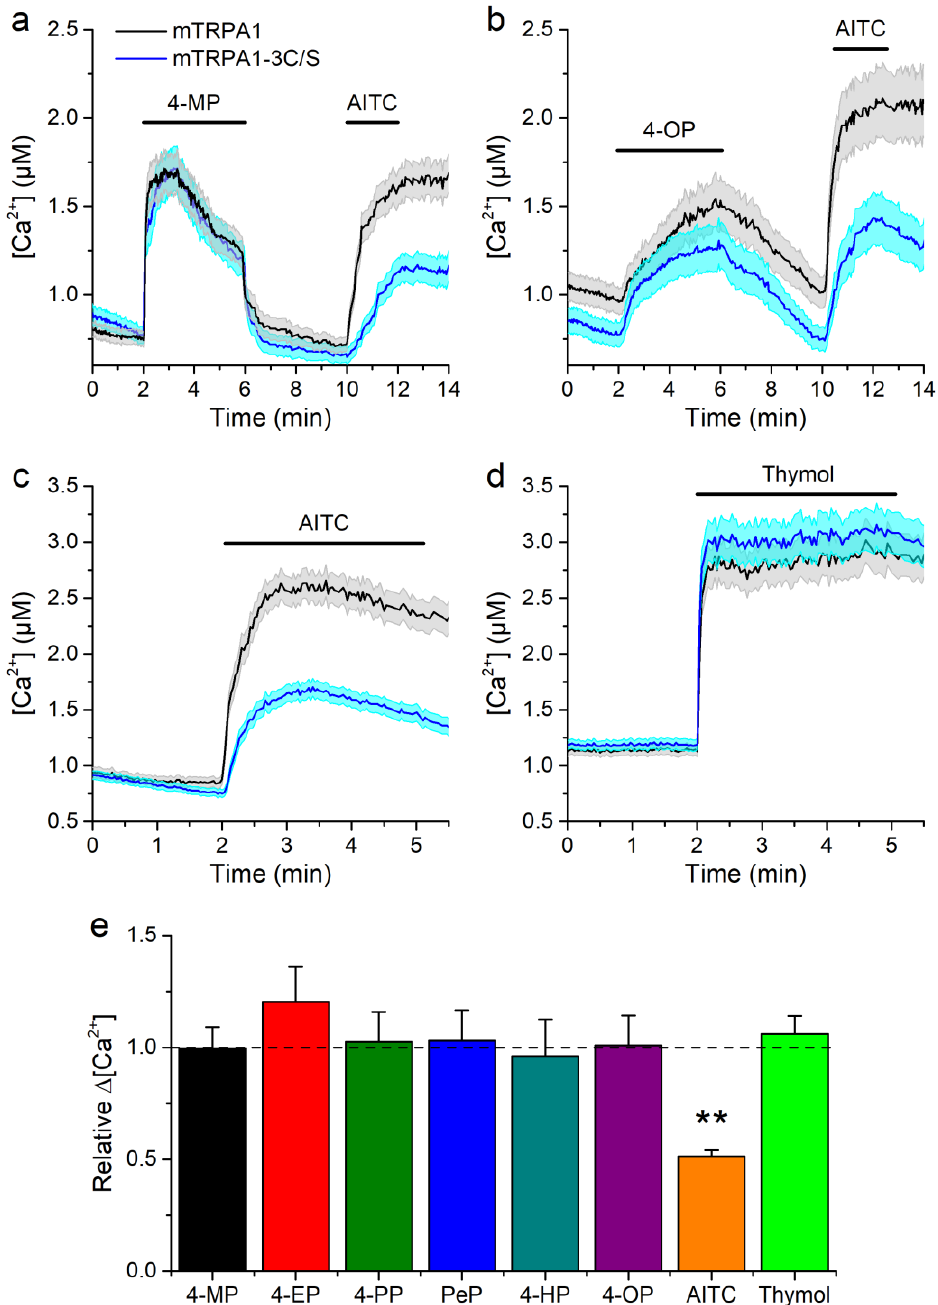
Figure 4. Responses to alkylphenols are not affected by mutation of mTRPA1 N-terminal essential residues. ( a – d ) Average traces of [Ca 2+ ] levels recorded in cells transfected with the wild type mTRPA1 or the triple cysteine mutant (mTRPA1-3C/S) in the presence of ( a , b ) 4-methylphenol, 1300 µ M ( c , d ) 4-octylphenol, 3.8 µ M and TRPA1 agonist AITC, 100 µ M. ( e ) Average [Ca 2+ ] amplitude change evoked by APs in wild type and mutant mTRPA1. APs were applied at concentrations 1300, 110, 60, 38, 10, 3.8 µ M for 4-MP, 4-EP, 4-PP, 4-PeP, 4-HP, 4-OP respectively, 100 µ M AITC and 300 µ M thymol. The error bars represent the standard error of the mean. All experiments were conducted in transfected HEK293T cells ( n > 50) (** p < 0.01, two-tailed Mann-Whitney U test).